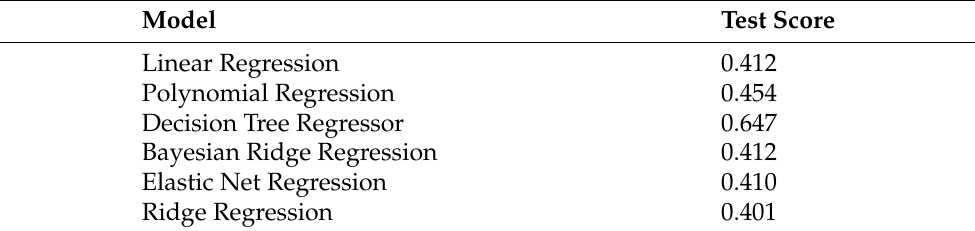
Table 3. Comparison of test score of various regression models on the same